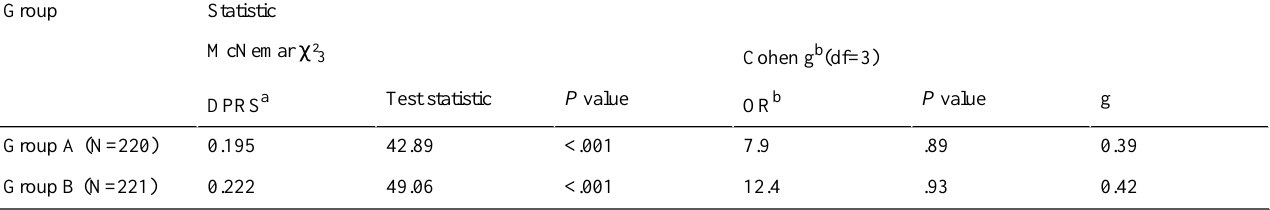
Table 9. McNemar chi-square, Cohen g, and odds ratio (OR): assessment 1 vs assessment 2. StatisticGroup